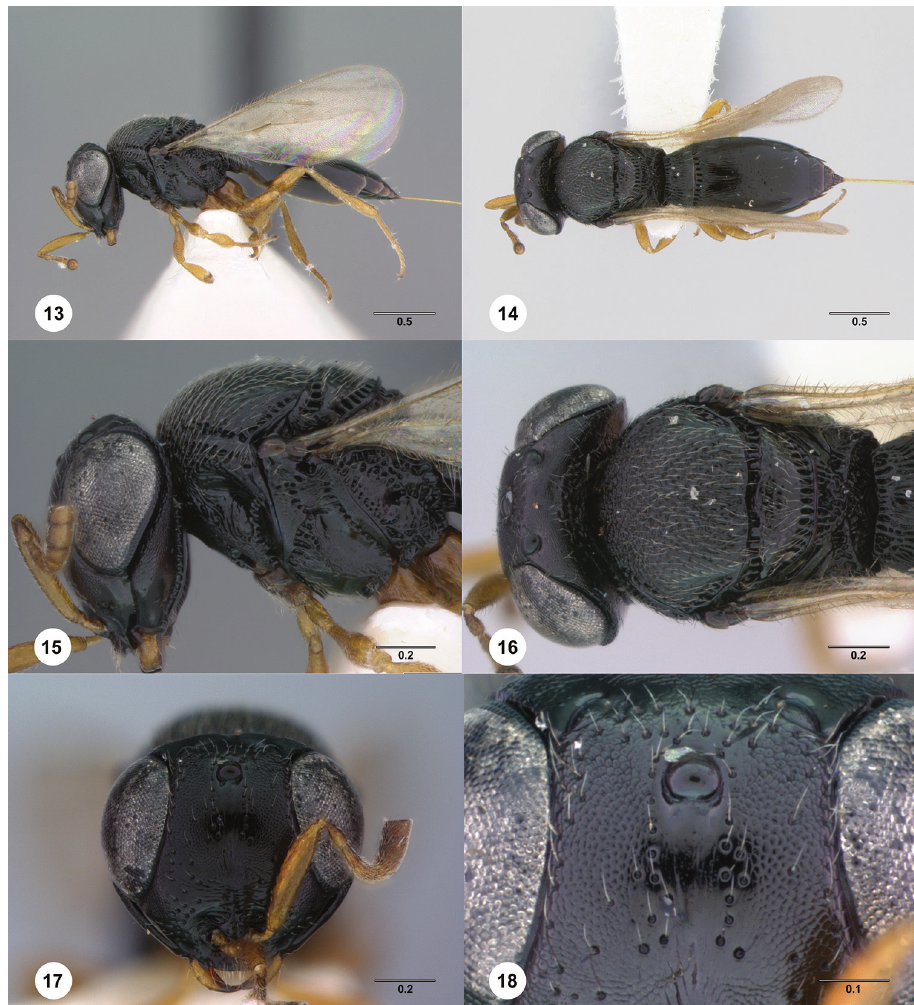
mesosoma, lateral view 16 Head, mesosoma, dorsal view 17 Head, mouthparts, anteroventral view 18 Frons, anteroventral view. Scale bar in